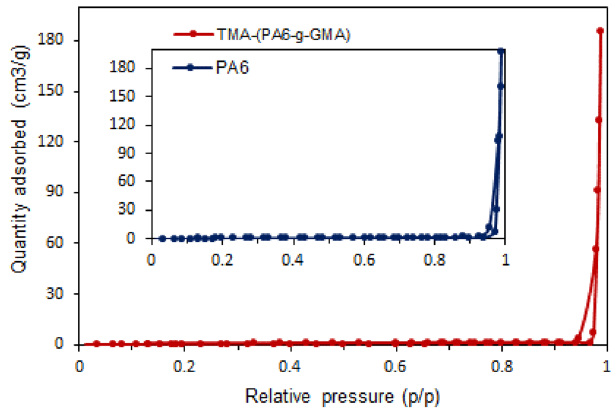
Figure 6. N 2 adsorption–desorption isotherm of PA6 (blue) and TMA-(PA6- g -GMA) (red).